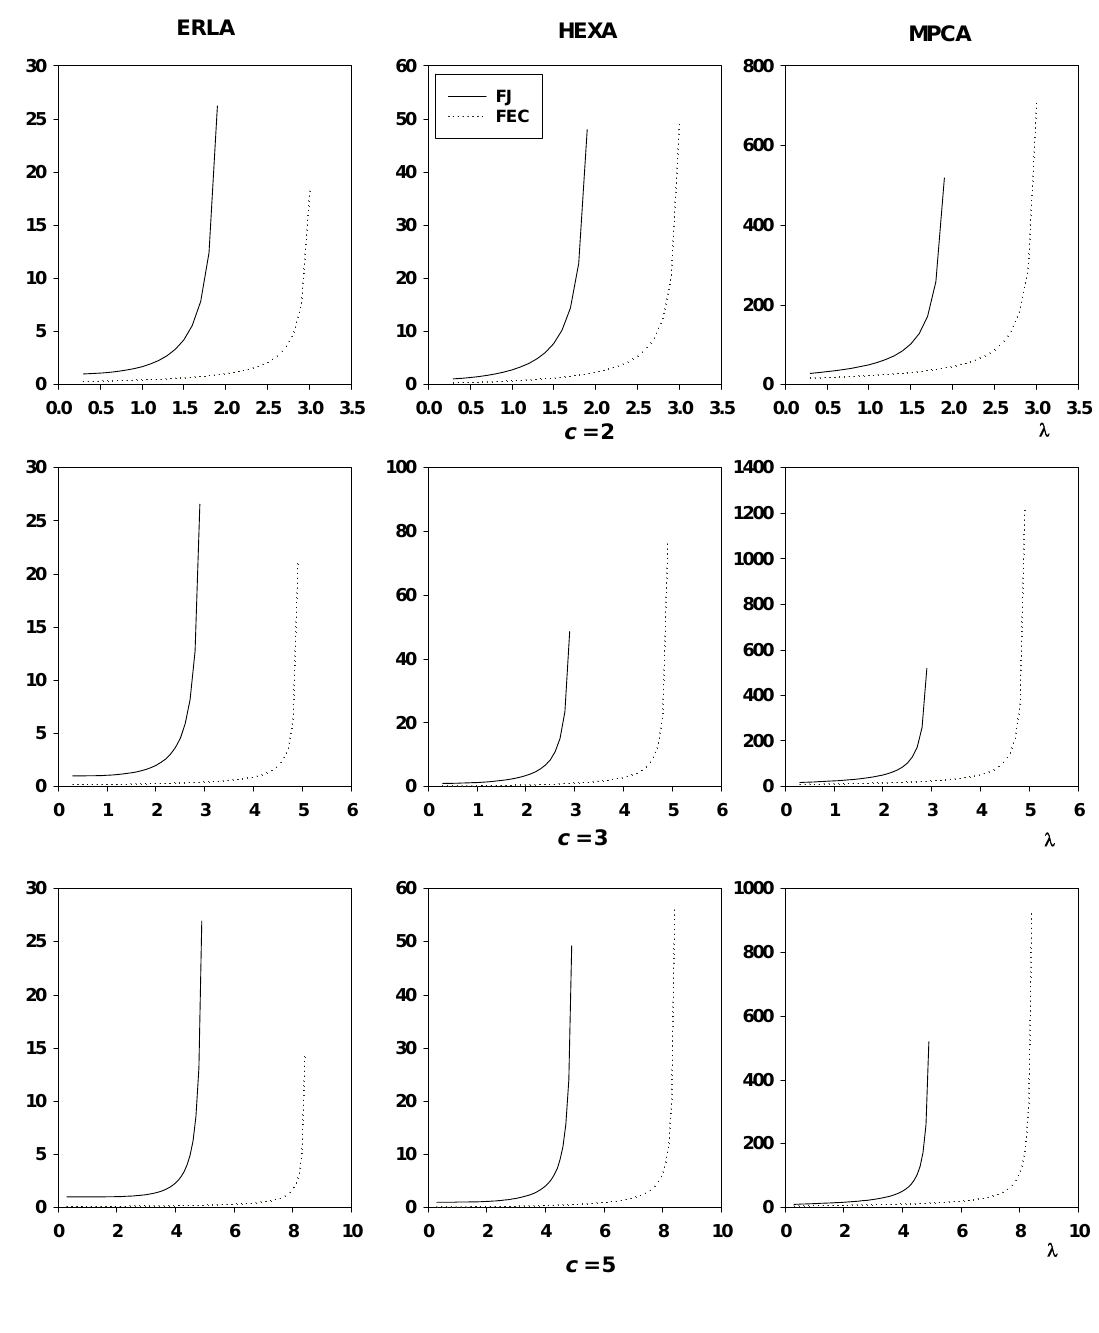
Figure 4: Plot of E ( L ) under various scenarios for hyperexponential